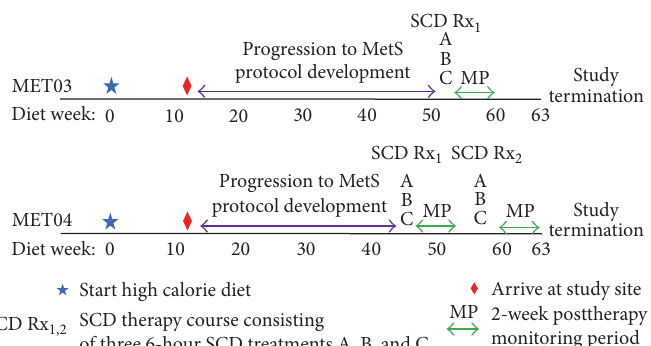
Figure 1: Schematic of the schedule of events for MET03 and MET04 over the progression to metabolic syndrome, SCD therapy protocol development,SCDRxcourses(definedasthree6-hourSCDtreatments(A,B,andC)overaone-weekperiod),2-weekposttherapymonitoring periods, and study termination, with respect to weeks on the atherogenic, high energy/high fat diet.